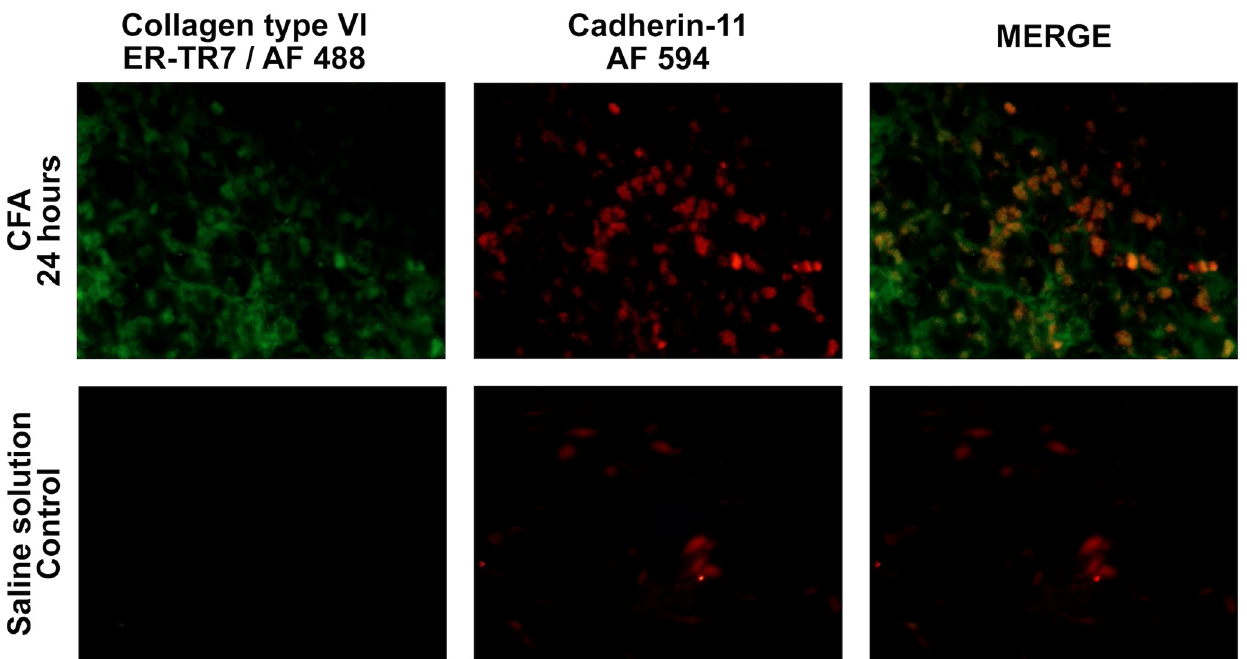
Figure 6. Immunodetection of Cadherin-11 and Collagen type VI in the rats’ footpads at 24 h post-Complete Freund’s adjuvant injection. Immunofluorescence was performed to co-localize Cadherin-11 (red) and Collagen type VI (fibroblast marker ER-TR7; green).